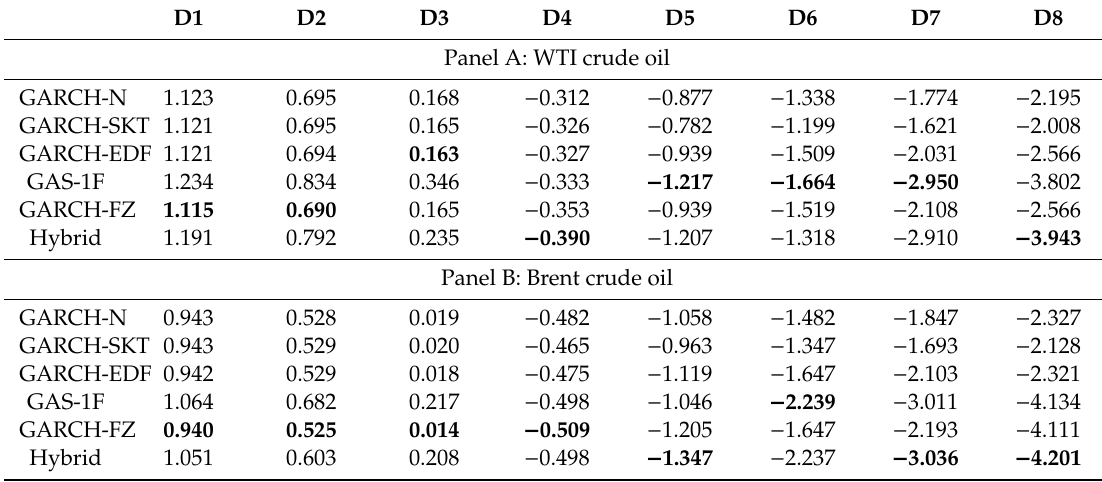
Table 6. The out-of-sample average losses for the wavelet details ( α = 0.05).